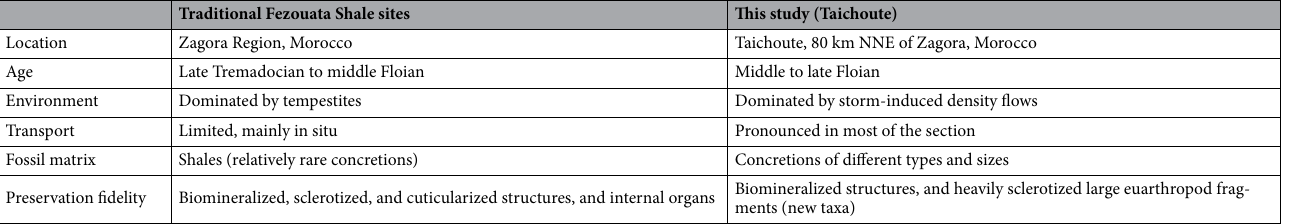
Table 1. Comparison between the newly discovered Fezouata Shale locality (Taichoute) and conventional